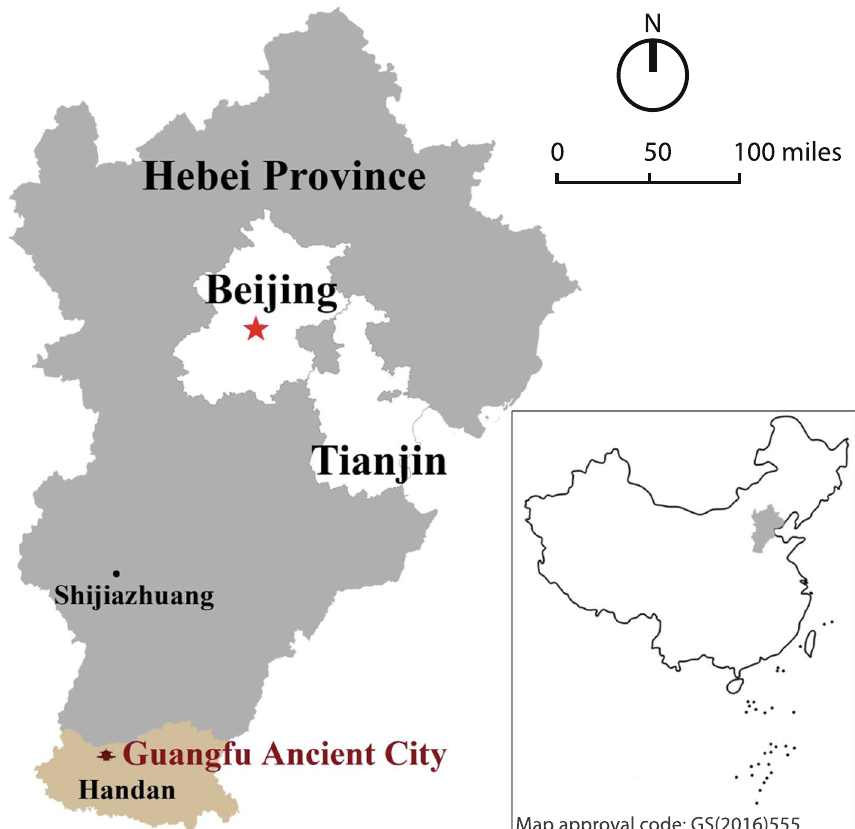
Fig. 3 The location of Guangfu Ancient City, Hebei Province, China (Source: the